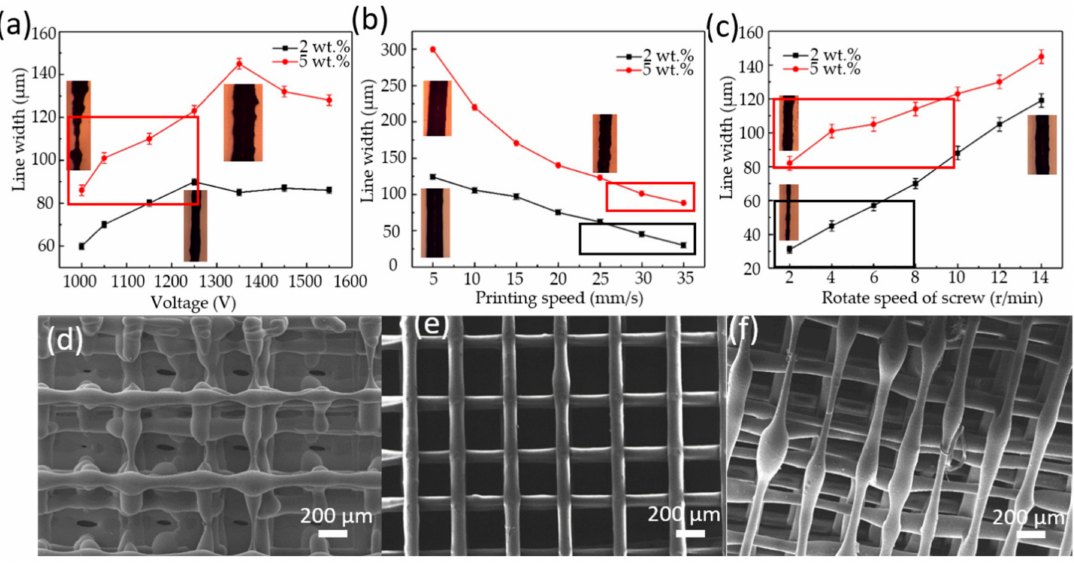
Figure 2. Influences of process parameters on the line width: ( a ) voltage; ( b ) printing speed; ( c ) screw speed, in which the red box and black box are the acceptable parameters for the 2 wt.% and 5 wt.%, respectively; The printed results of polylactic acid (PLA) / multi-walled carbon nanotube (MWCNT) compositewithloadingof5wt.%intheconditionof: ( d )underfeeding; ( e )properfeeding; ( f